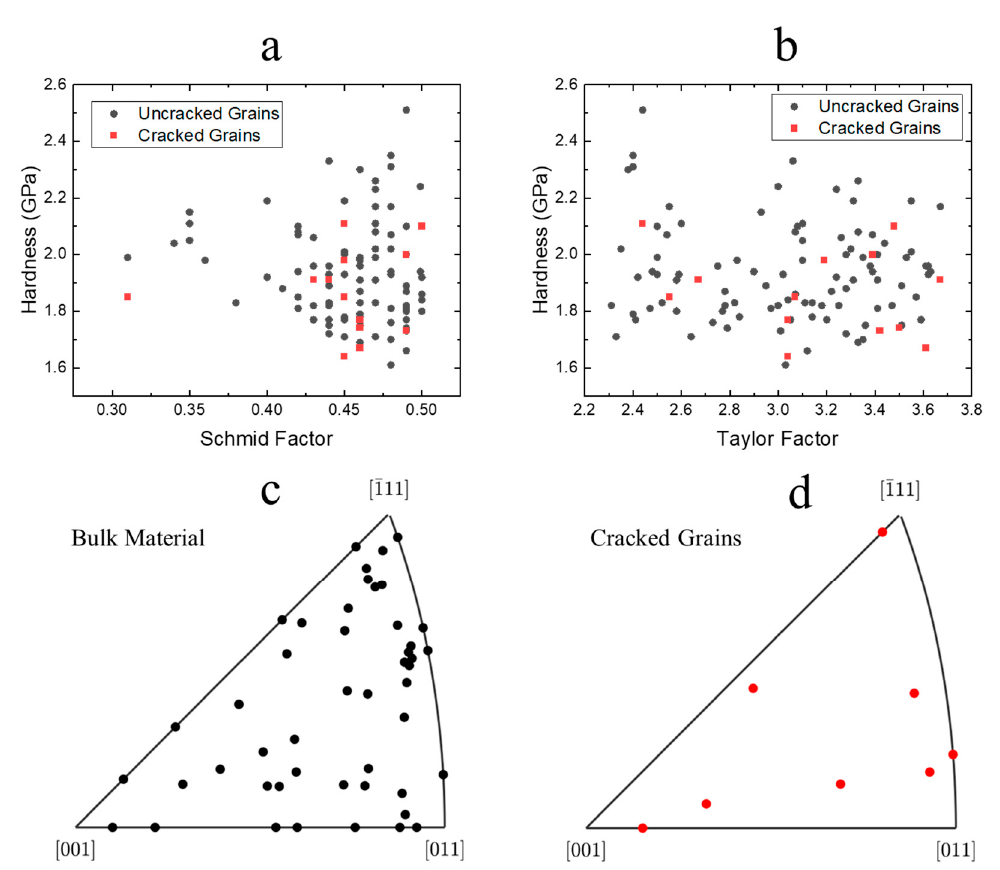
Figure 6. Hardness distribution of uncracked and cracked grains as a function of their ( a ) Schmid factor and ( b ) Taylor factor; IPF of the grain orientations for ( c ) bulk material and ( d ) cracked grains.